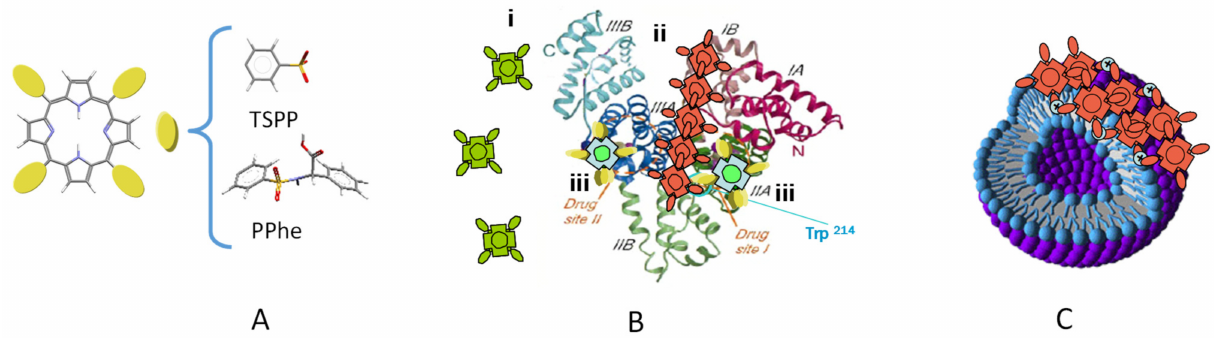
Figure 2. ( A ) Molecular structure of meso -substituted porphyrins. TPPS interaction with ( B ) HSA and ( C ) DMPC vesicles: Monomers (green), J-aggregates (red), TPPS–HSA complex (yellow). Adapted with permission from [27] Copyright © 2008, John Wiley and